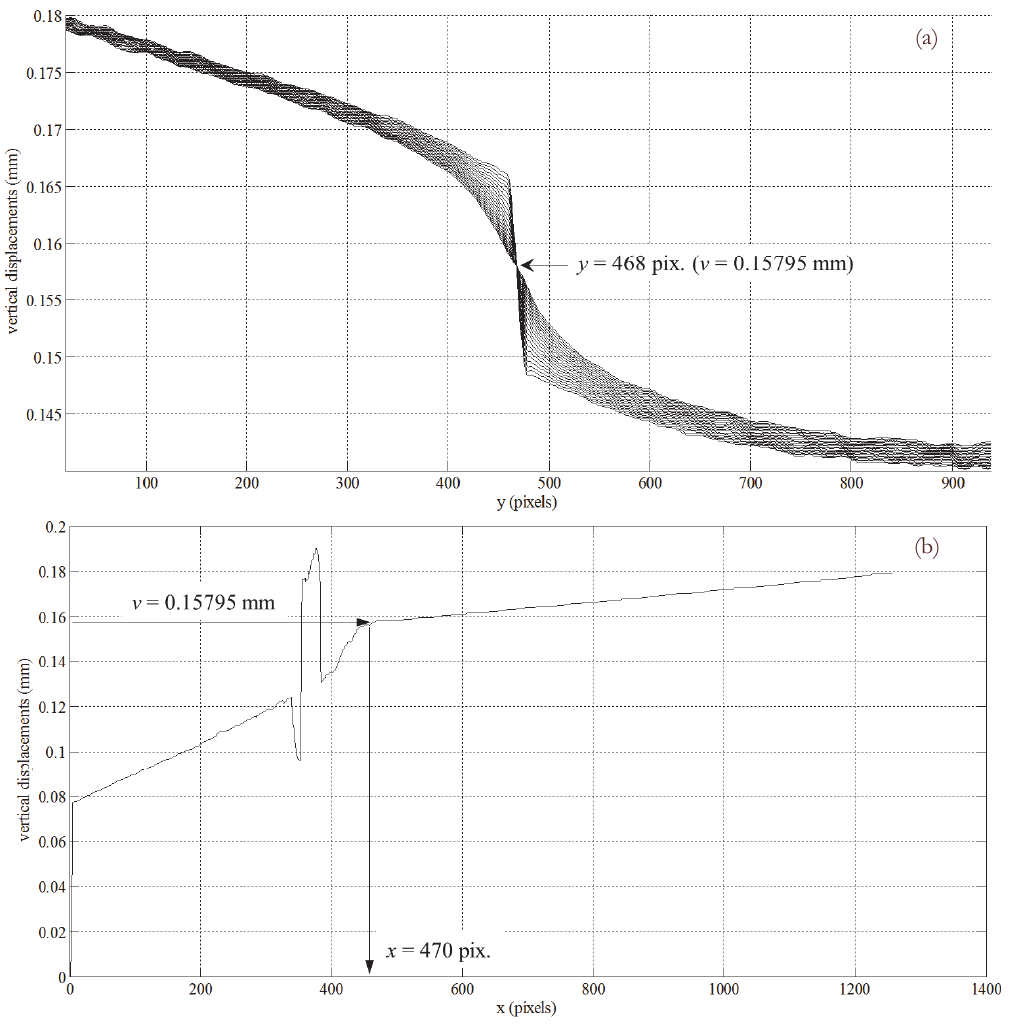
Figure 3: Methodology for locating the crack tip: (a) y -coordinate and (b) x